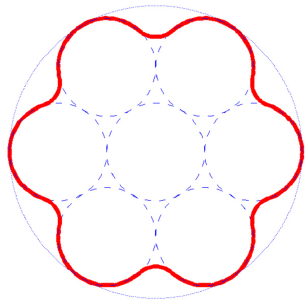
Figure 9. Simplified representation of the cross ‐ section of artichoke fiber.